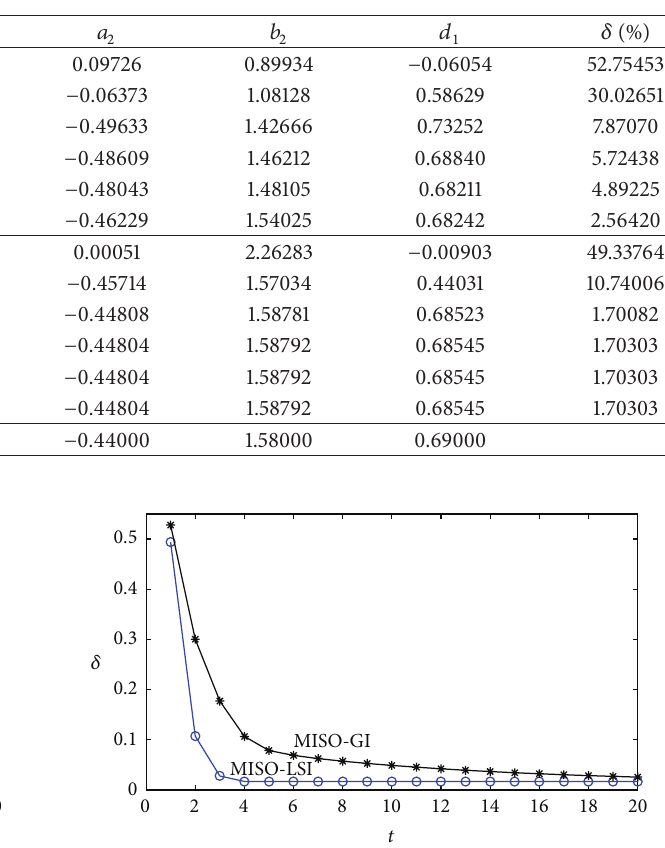
Table 2: The MISO-GI and MISO-LSI estimates and errors ( 𝜎 2 = 1.00 2 ).